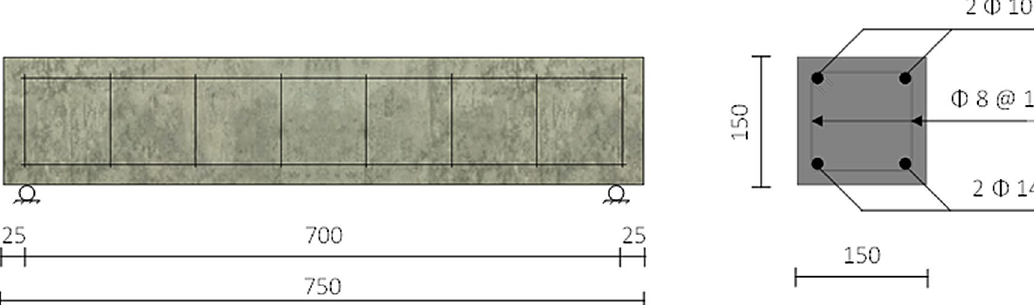
Fig. 2 RC beam with stirrups (All dimensions in